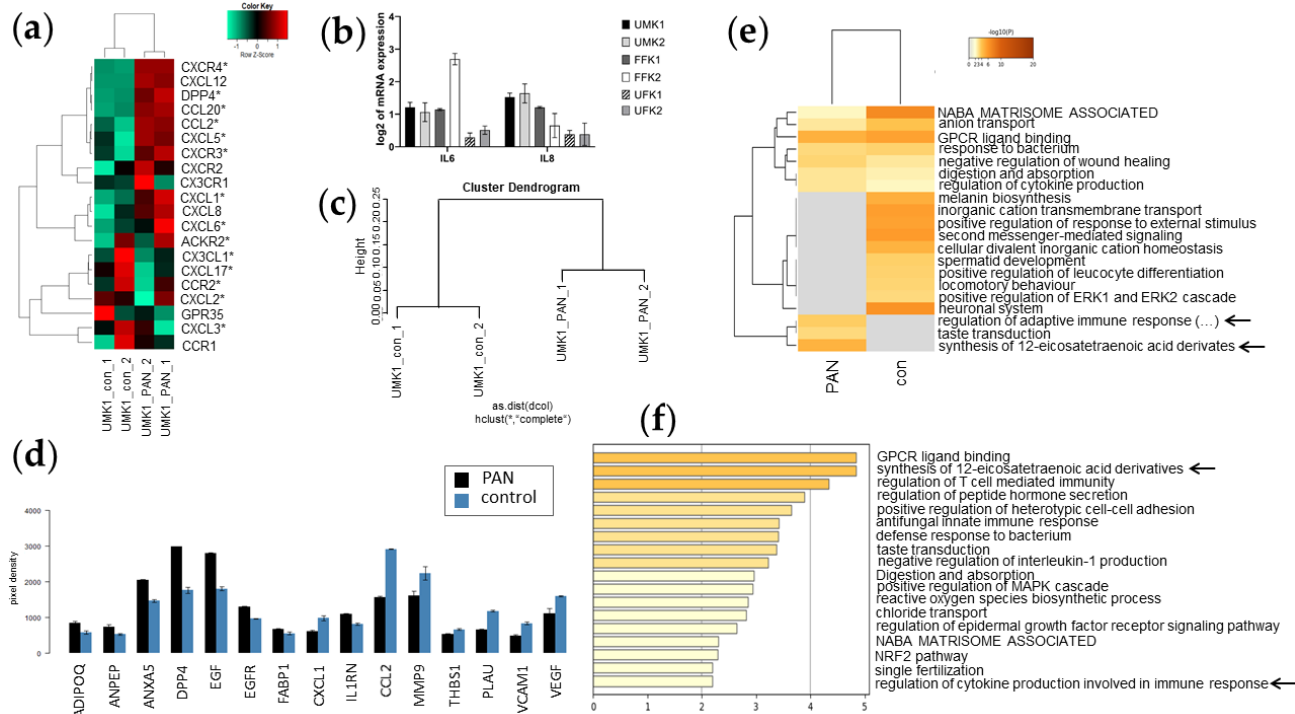
Figure 6. Inflammation-associated gene expression and cytokine secretion in untreated and PAN- treated kidney organoids. ( a ) Pearson heatmap of the expression of immune-related genes in control and PAN treatment. ( b ) Expression of IL-6 and IL-8 is elevated in PAN-induced kidney organoids as measured by qRT-PCR. Error bars depict standard error. ( c ) Cluster dendrogram with the technical duplicates of untreated kidney organoids clustering together and the PAN-treated kidney organoids cluster separately. ( d ) Cytokine array data comparing expression between untreated control and PAN treatment. ( e ) Metascape-generated heatmap comparing UMK1_PAN and UMK1_con included inflammation- and immune-response-related GOs. Subjected gene-sets are based on the Venn analysis in Figure 4. ( f ) Bar graph of non-redundant enrichment clusters after PAN treatment.